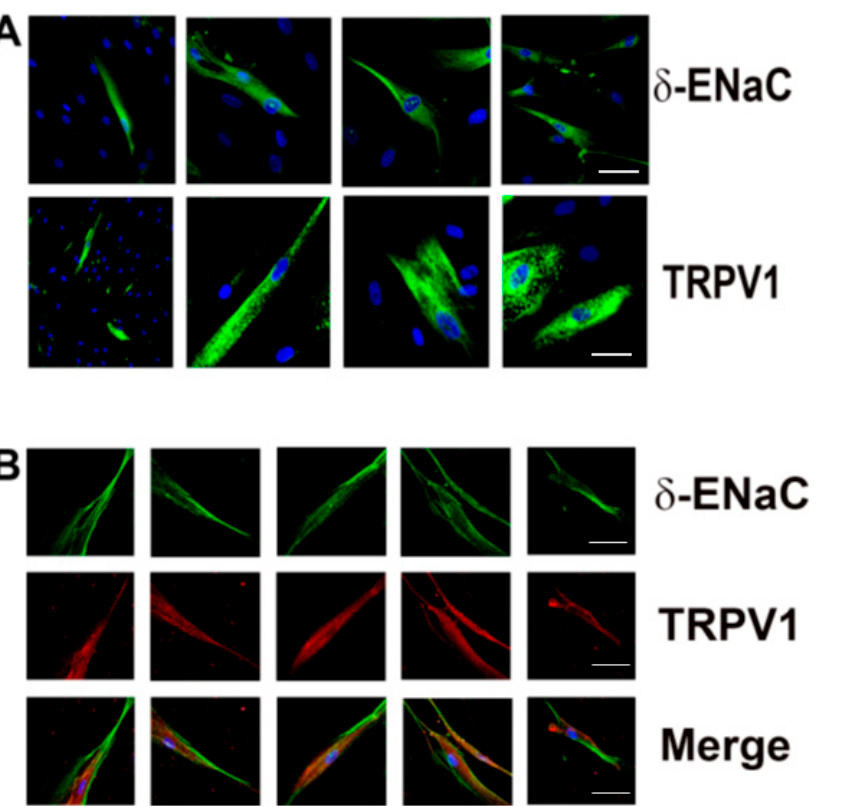
Figure 5. Co-localization of δ -ENaC and TRPV: ( A ) localization of δ -ENaC and TRPV1 in HBO cells; blue DAPI-stained cell nuclei and green δ -ENaC or TRPV1 antibody binding; the left column shows low magnification (20×) images; the remaining panels are high-magnification images (40×) that show δ -ENaC or TRPV1 antibody binding in individual cells; ( B ) localization of TRPV1 in individual δ -ENaC-positive HBO cells at 40× magnification; green δ -ENaC antibody binding; red TRPV1 antibody binding. Scale bars 10 µm.